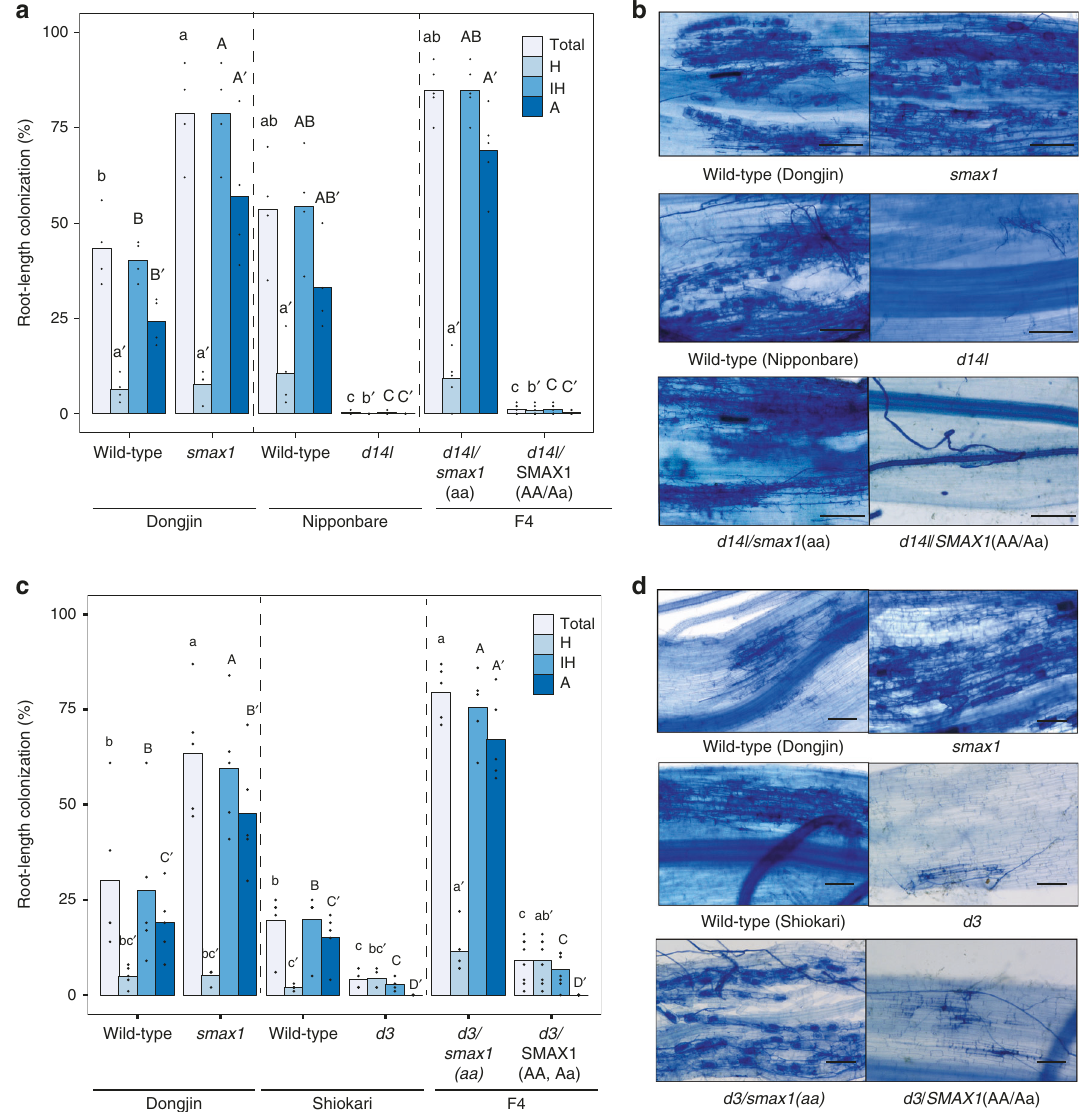
Fig. 2 SMAX1 functions downstream of the karrikin receptor complex. Root colonisation of mutant and wild-type rice genotypes by R. irregularis . a AM colonisation levels of a cross between smax1 and the karrikin receptor mutant, dwarf 14-like ( d14l ), are quanti fi ed as a percentage (%) at 6 wpi with 300 spores. Dongjin and Nipponbare refer to the wild-type cultivars of respective mutant. F4 indicates the fourth generation progeny from the initial cross; d14/smax1 (aa) indicates double homozygous alleles, whereas d14SMAX1 (AA, Aa ) refers to homozygous d14l with either wild-type or heterozygous SMAX1 alleles. Each bar indicates the average percentage value of the respective fungal structure. Total total colonisation, H hyphopodia, IH intraradical hyphae, A arbuscules. Kruskal-Wallis test was performed, followed by post-hoc pairwise comparison using the Agricolae R package. Different letters represent signi fi cant difference (p-value <0.05). Degrees of freedom = 5, Dongjin wild-type ( n = 4), smax1 ( n = 4), Nipponbare wild-type ( n = 4), d14l ( n = 4), d14l/ smax1 (F4, n = 5), d14l /SMAX1 (F4, n = 8), Total: χ 2 = 25.08, p = 0.0001; H: χ 2 = 17.84, p = 0.003; IH: χ 2 = 25.15, p = 0.0001; A: χ 2 = 25.67, p = 0.0001. b Micrographs of trypan blue stained roots for fungal structures in d14l/smax1 and their parental lines . Images represent roots from at least three independent plants of each genotype. Total total colonisation, H hyphopodia, IH intraradical hyphae, A arbuscules. Scale, 100 μ m. c AM colonisation levels of crosses between smax1 and dwarf3 ( d3 ). Dongjin and Shiokari refer to the wild-type cultivars of respective mutant. F4 indicates; d3/smax1(aa) indicates double homozygous alleles and d3/smax1 (AA, Aa) refers to homozygous d3 with either wild-type or heterozygous SMAX1 alleles. Degrees of freedom = 5, Dongjin wild-type ( n = 5), smax1 ( n = 5), Shiokari wild-type ( n = 5), d3 ( n = 4), d3/smax1 (F4, n = 5), d3 /SMAX1 (F4, n = 8), Total: χ 2 = 26.01, p = 0.0001; H: χ 2 = 13.42, p = 0.02; IH: χ 2 = 25.65, p = 0.0001;A: χ 2 = 29.33, p = 2E0-5. d Micrographs of trypan blue stained roots for fungal structures in d3/smax1 and their parental